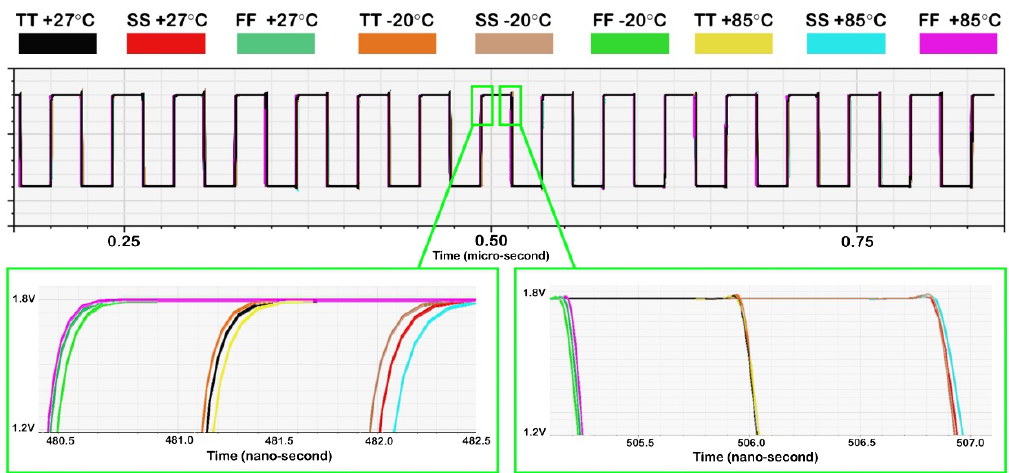
Figure 9. Process corners/temperatures simulation for the recovered clock.